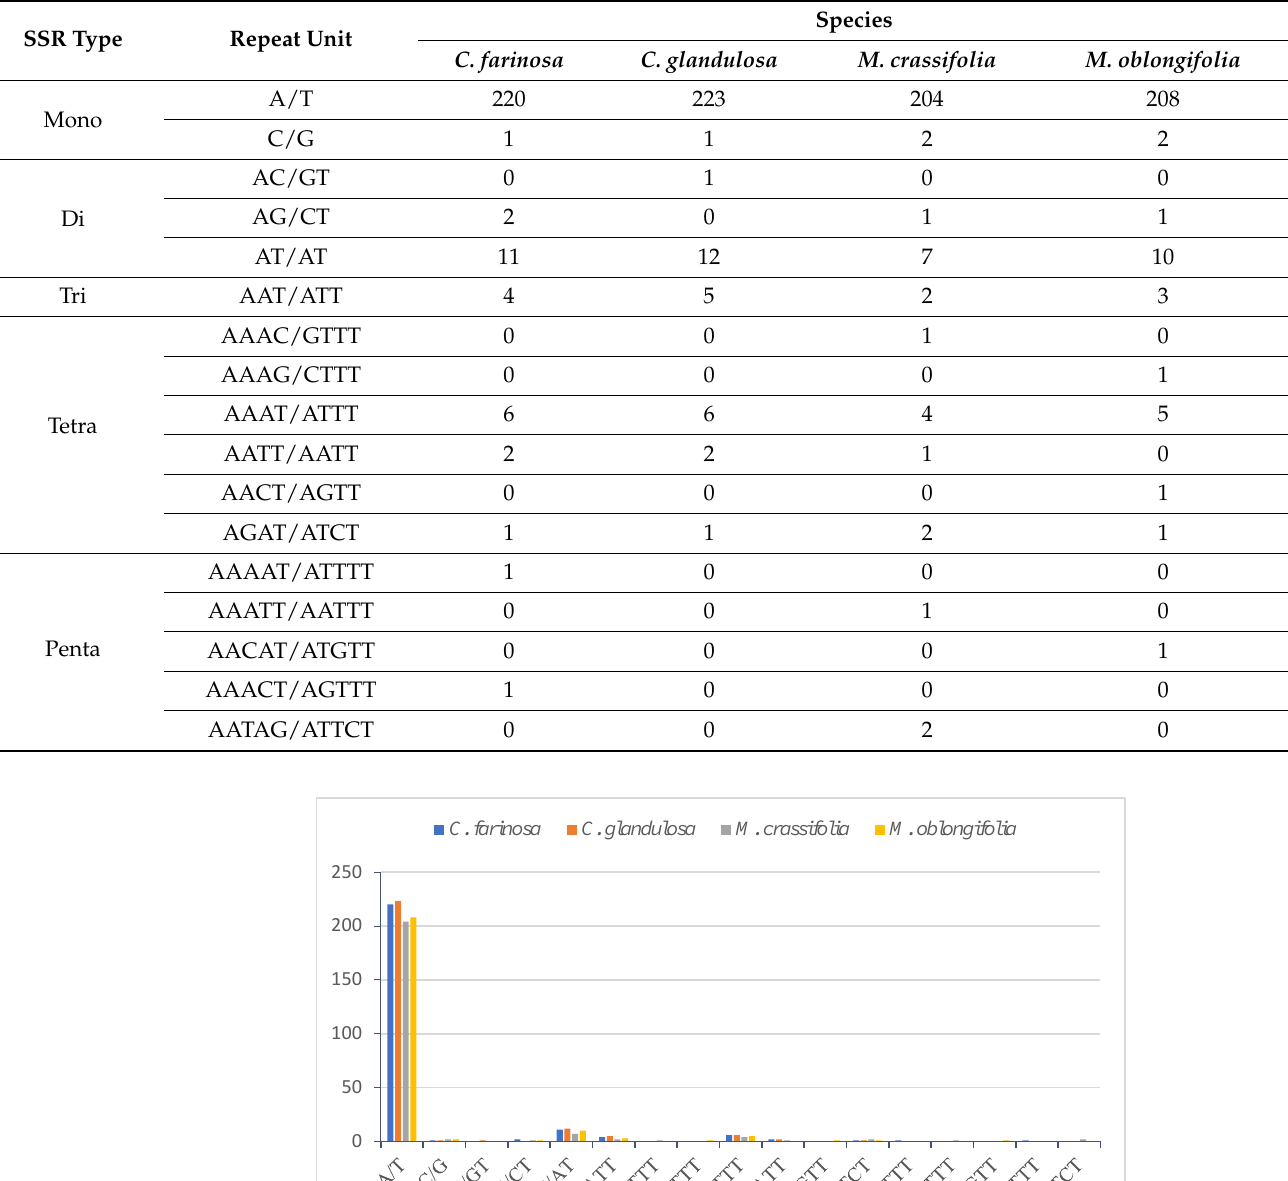
Table 3. Simple sequence repeats in the C. farinosa , C. glandulosa , M. crassifolia and M. oblongifolia chloroplast genomes.